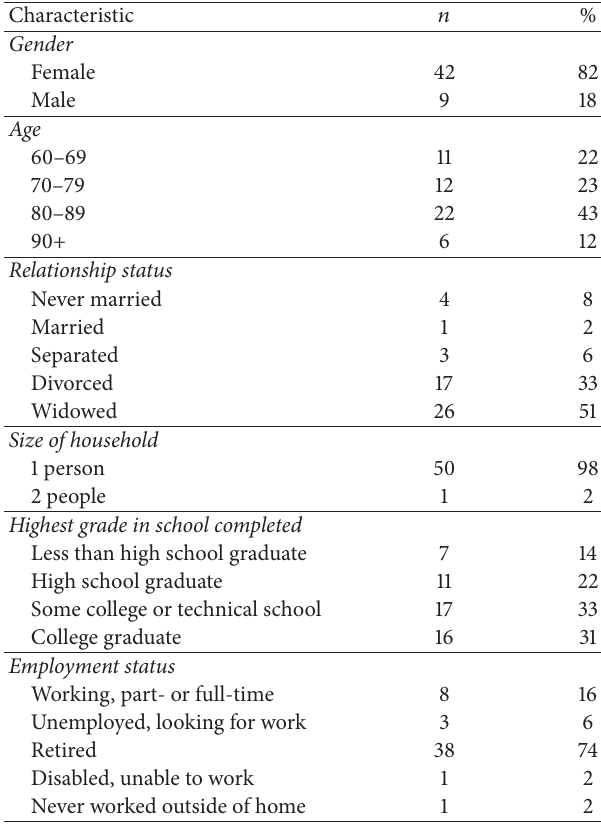
Table 1: Participant characteristics 𝑛 = 51